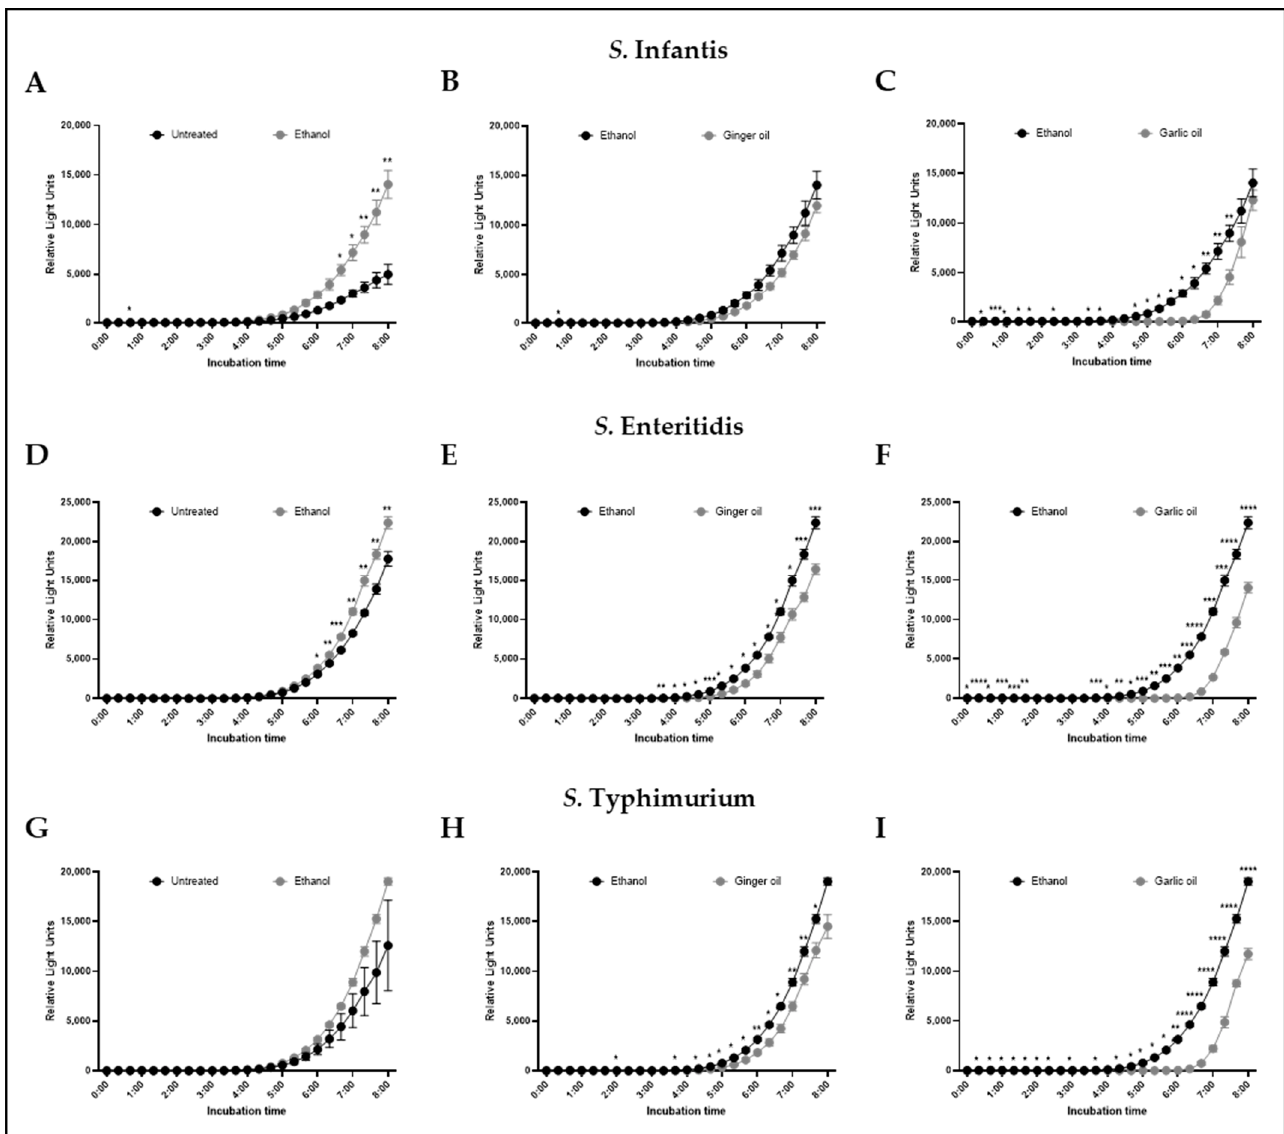
Figure 3. Effect of ethanol, ginger oil, and garlic oil at SIC dose on AI-2 levels of S. Infantis ( A – C ), S. Enteritidis ( D – F ), and S. Typhimurium ( G – I ) determined by bioluminescence assay. Results are averages of two independent experiments, each containing duplicate samples (mean and STD). * p < 0.05; ** p < 0.01; *** p < 0.001; **** p < 0.0001.